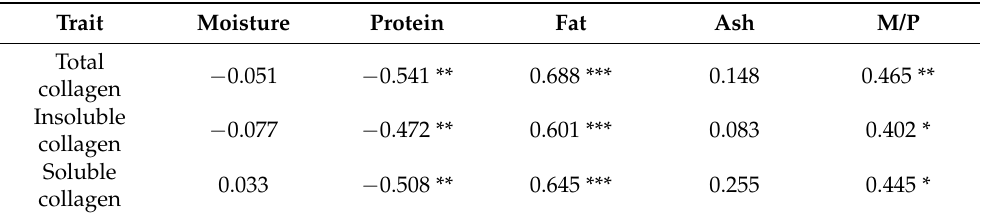
Table 4. The Pearson correlations for collagen fractions concentration (mg/g) and proximate compo- sition (%) of raw muscle tissue of beaver ( n = 30). Trait Moisture Protein Fat Ash M/P Total − 0.051 − 0.541 ** 0.688 *** 0.148 0.465 ** collagen Insoluble − 0.077 − 0.472 ** 0.601 *** 0.083 0.402 * collagen Soluble 0.033 − 0.508 ** 0.645 *** 0.255 0.445 * collagen